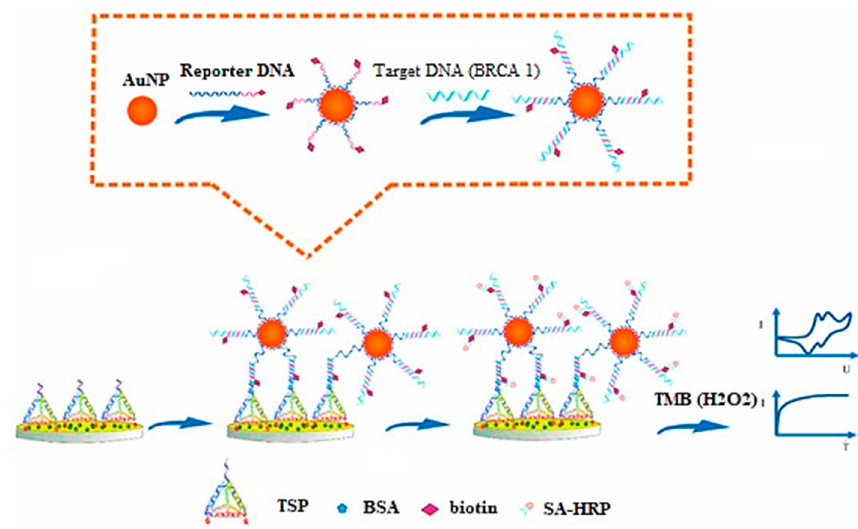
Figure 2. Principle for development of DNA-based electrochemical gold nano-sensors, reprinted from [115] .